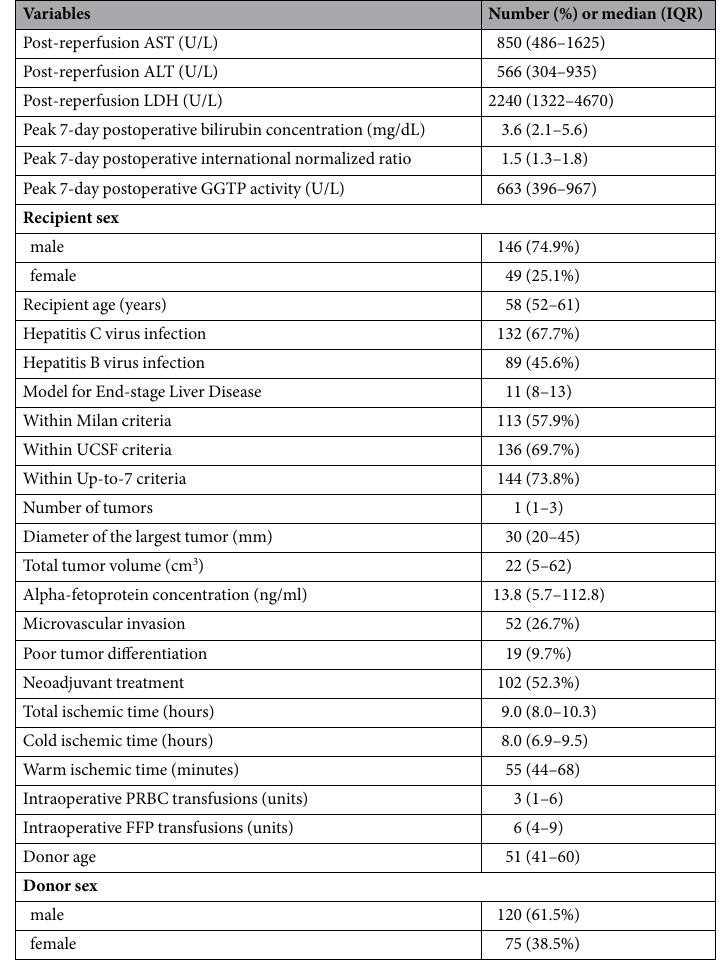
Table 1. Recipient, donor, and operative characteristics of 195 liver transplant recipients with hepatocellular carcinoma included in the study. IQR – interquartile range; AST – aspartate transaminase; ALT – alanine transaminase; LDH – lactate dehydrogenase; UCSF – University of California, San Francisco; PRBC – packed red blood cells; FFP – fresh frozen plasma.